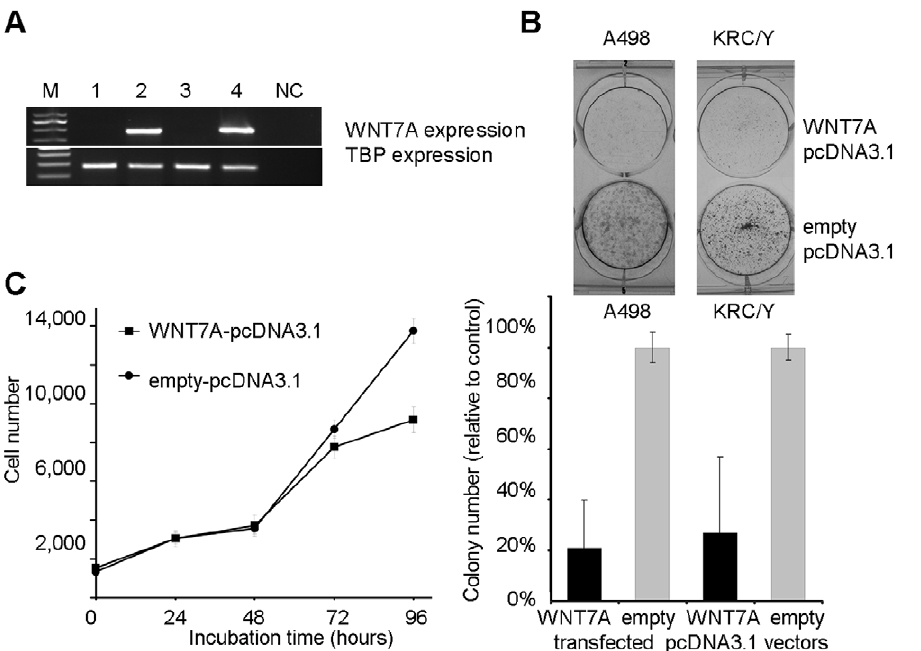
Figure 4. Suppressive effect of WNT7A gene re-expression in RCC cell lines. Effect of WNT7A gene re-expression (A) on colony formation (B) for the A498, KRC/Y cell lines, and (C) cell proliferation assays for the A498 cell line; M – marker, 1 and 2– A498 cells were transfected by empty- pcDNA3.1 and WNT7A-pcDNA3.1 vectors, 3 and 4– KRC/Y cells were transfected by empty-pcDNA3.1 and WNT7A-pcDNA3.1 vectors, NC – negative control